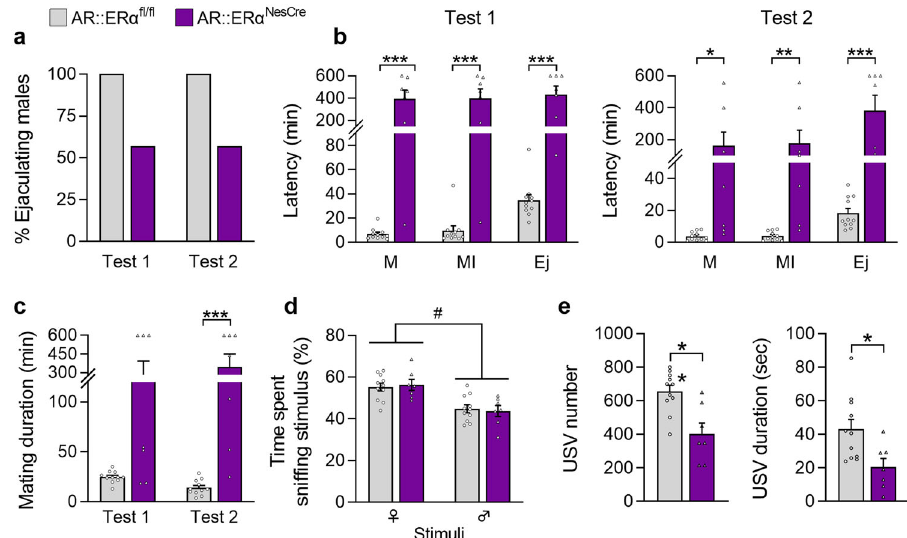
Fig. 5 The behavioral effects of double AR :: ER α deletion in males. a Percentage of control (AR::ER α fl / fl ) and mutant (AR::ER α NesCre ) males reaching ejaculation in tests 1 (naive animals) and 2 (sexually experienced animals). Data are shown as percentages. b Behavioral components of sexual behavior for control and mutant males ( n = 7 – 11 per genotype). Latencies to mount (M), intromit (MI) and to reach ejaculation (Ej) in Tests 1 and 2; * p < 0.05, ** p < 0.01, *** p < 0.001 versus controls. c Mating duration from the fi rst mount until ejaculation; p = 0.2 for Test1 and *** p < 0.001 for Test 2 ( n = 7 – 11 per genotype). d Olfactory preference of sexually experienced controls and mutants ( n = 7 – 11 per genotype) expressed as the percentage of total time spent